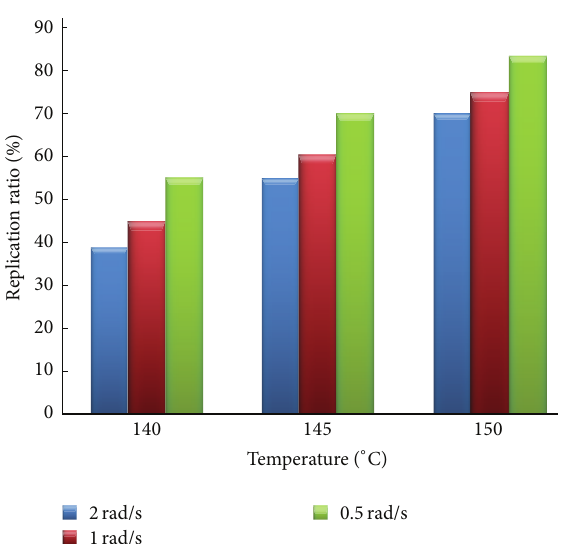
Figure 6: A changing chart in which replication rate changed with rolling depth.